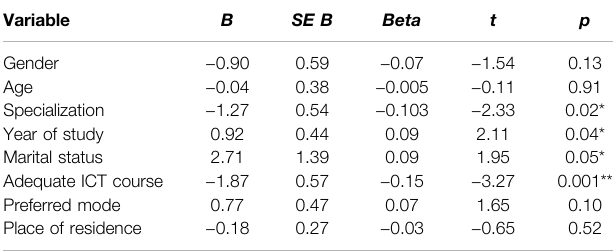
TABLE 4 | Summary of demographic variables predicting independent learning.